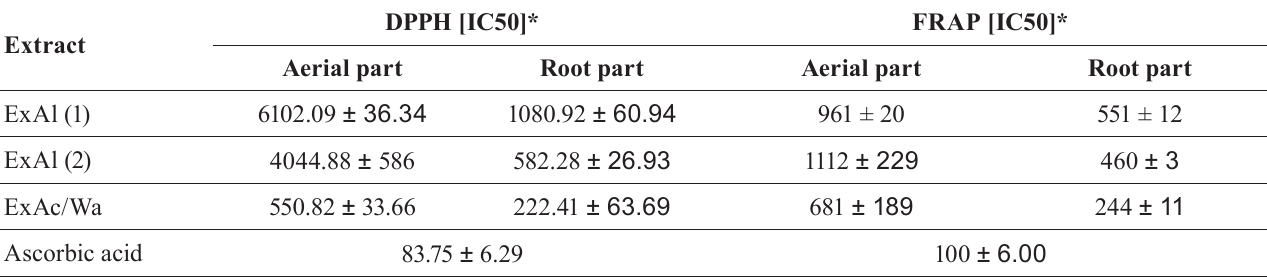
TABLE III - Results of the antioxidant activity of Haloxylon scoparium extracts, containing the alkaloids, by both tests (DPPH and FRAP)